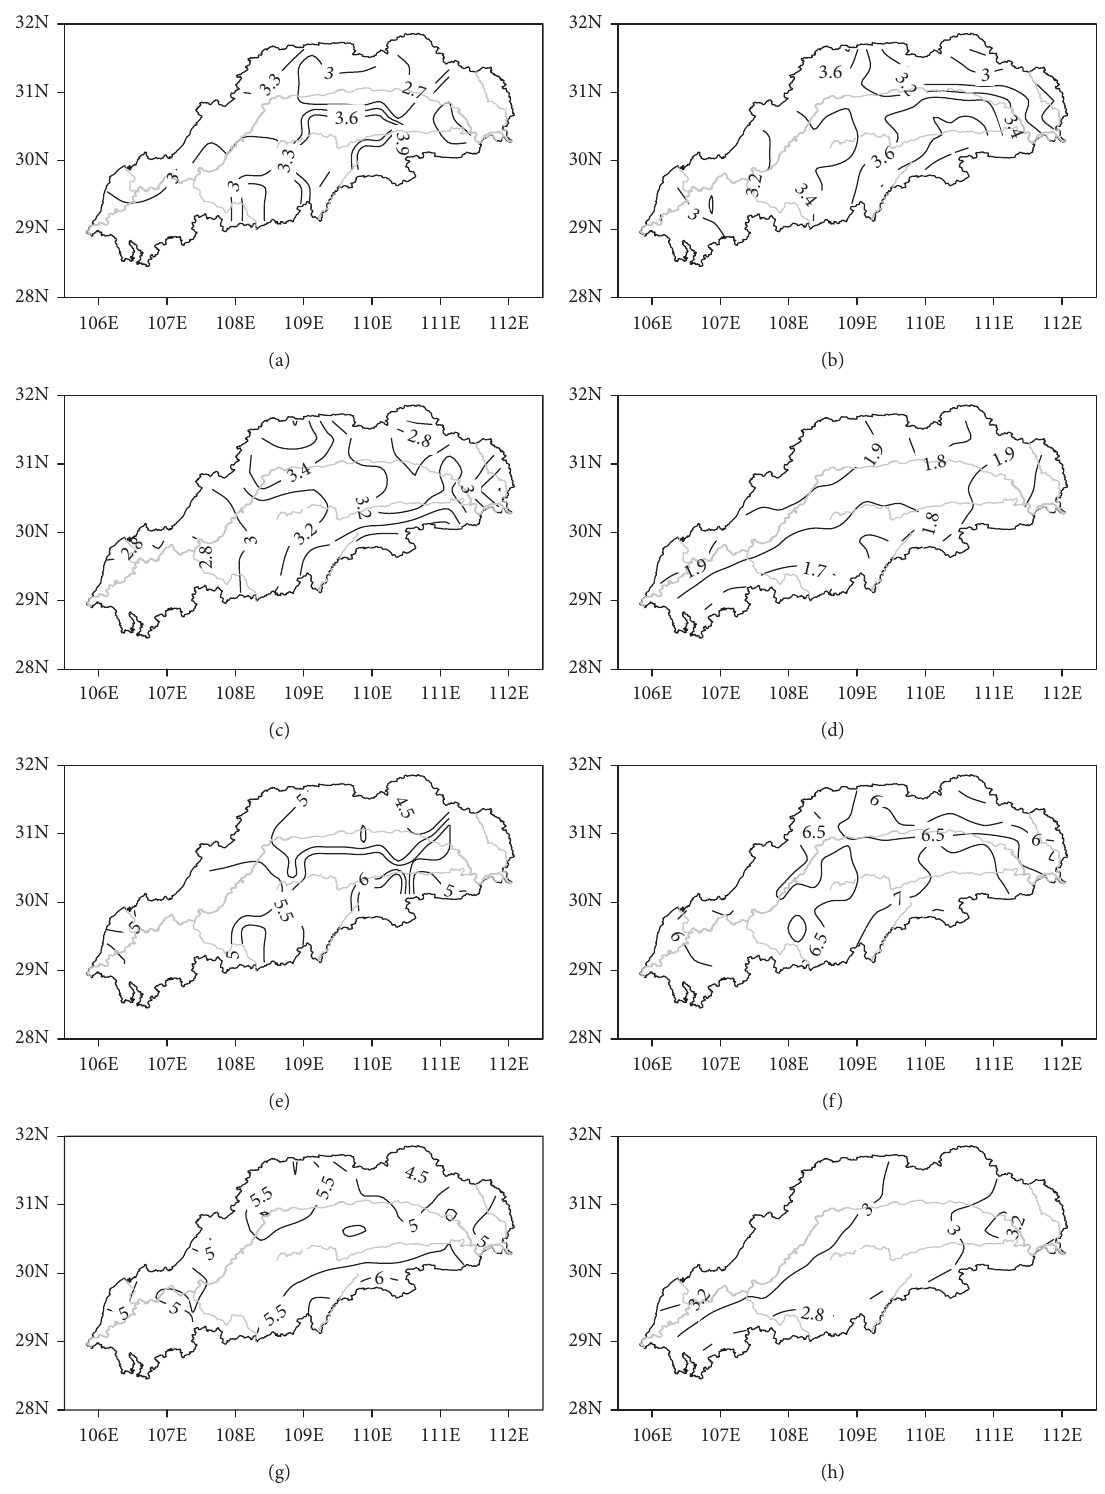
Figure 2: The spatial distribution of annual mean precipitation (contour units: mm/day) and the mean standard deviation of 3-hourly precipitation rate (contour units: mm/day) for (a, e) gauge observation, (b, f) TRMM, (c, g) CMORPH, and (d, h)